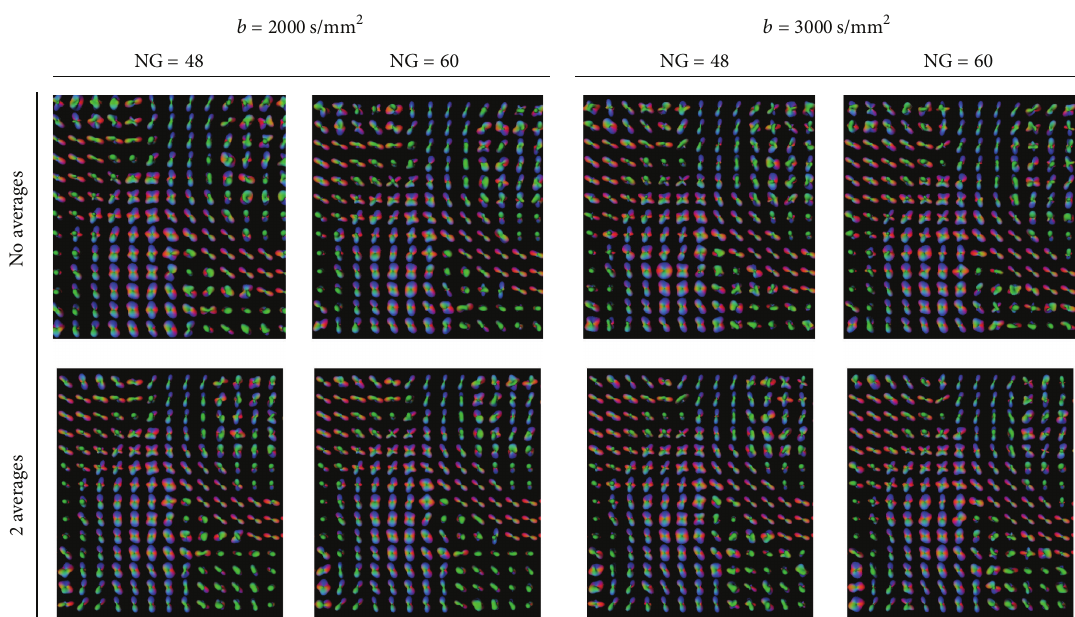
Figure 15: The effect of the averaging of the data at 𝑙 = 4 in a Q-ball glyph representation. There is not a significant difference between the quality of the data without and with averaging even at higher 𝑏 -values.